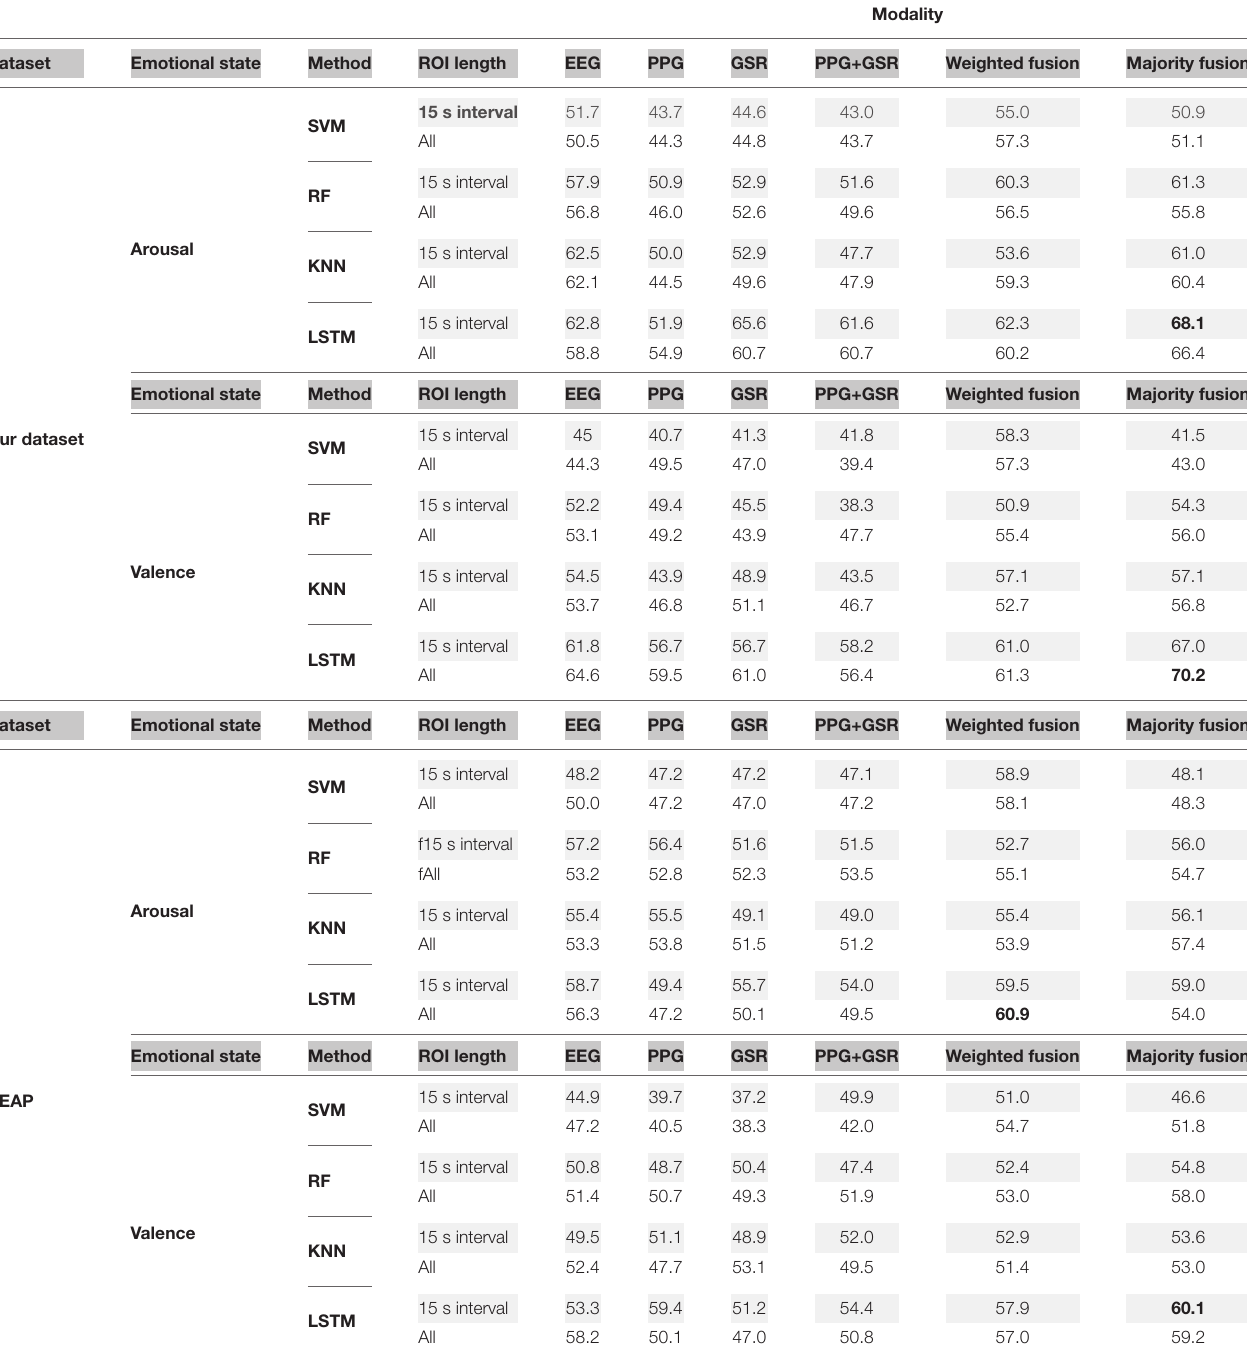
TABLE 6 | Comparison of F-Score value of LSTM, RF, SVM, and KNN methods when ROI of 15 s or all of data was